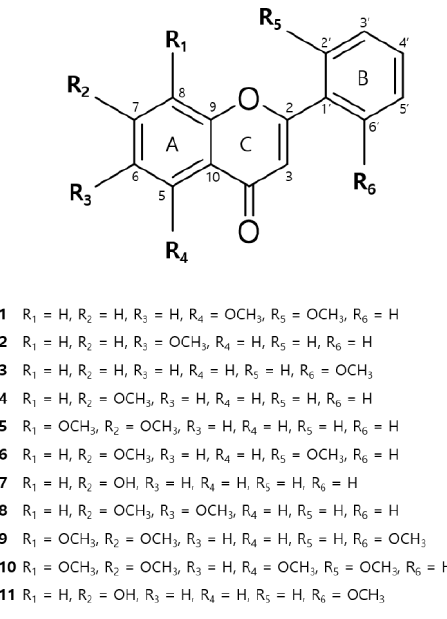
Figure 4. Chemical structures of the compounds isolated from DCE. The active compound 5 exhibits a peak at m / z 283.0974 [M+H] + in HREISMS, corre- sponding to its molecular formula as C 17 H 14 O 4 . The 1 H NMR spectrum of 5 indicated five aromatic protons of B-ring at δ H 8.08 (m, 2H, H-2 (cid:48) , H-6 (cid:48) ), 7.61 (m, 3H, H-3 (cid:48) , H-4 (cid:48) , H-5 (cid:48) ), and ortho -coupling protons of A-ring at δ H 7.79 (d, J = 8.9 Hz, 1H, H-5), 7.29 (d, J = 8.9